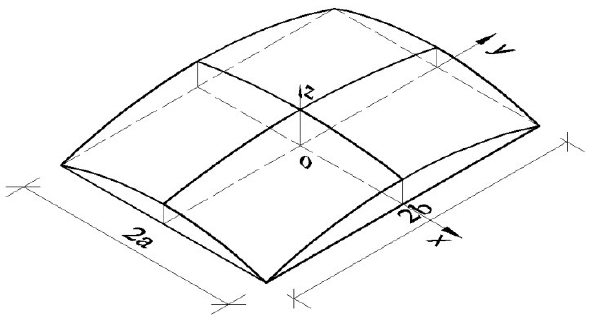
Figure 1: A rectangular shallow shell with dimensions 2a × 2b , on which a uniform vertical load of intensity q (kN/m2) acts over the entire surface